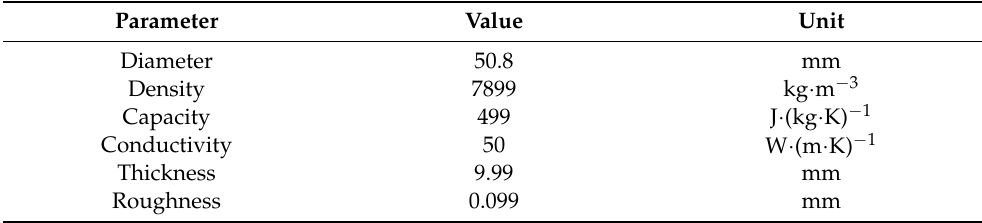
Table 1. Properties of the piping